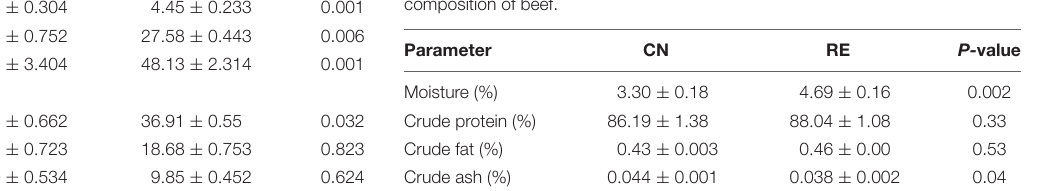
TABLE 4 | Effects of herbal tea residue feed on the basic nutritional composition of